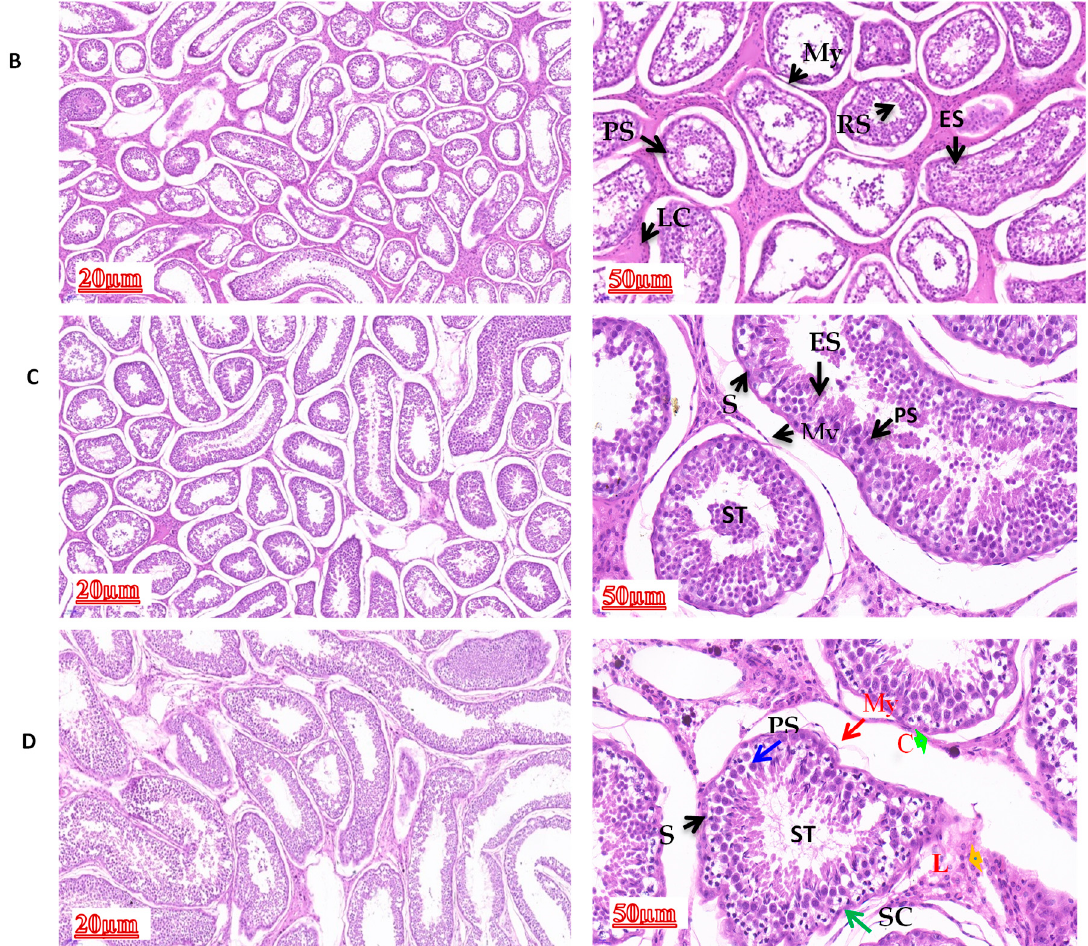
Figure 1. Morphological evaluations of testicular tissues at different ages: ( A ) 6, ( B ) 18, and ( C ) 30 months, and ( D ) 6 years. Different structures were found: myoid cell (My; red arrow), capillary (C), Leydig cell (L), spermatogonium (S; black arrowhead), Sertoli cell (SC; green arrow), primary spermatocyte (PS; Blue arrow), elongated spermatid (ES; Yellow arrow), Seminiferous tubule (ST). Scale bars = 20 µm (10×) and 50 µm (20×).